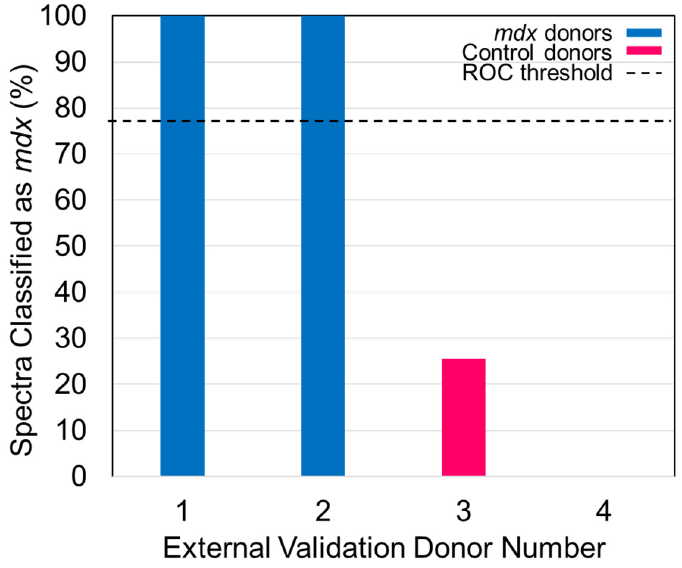
Figure 7. The percentage of spectra classified as belonging to the mdx model of mice is plotted as the bar height of each of the donors. The 77% threshold is plotted as the dashed line. Reprinted with permission from N. M. Ralbovsky, P. Dey, A. Galfano, B. K. Dey, and I. K. Lednev, Diagnosis of a model of Duchenne muscular dystrophy in blood serum of mdx mice using Raman hyperspectros-